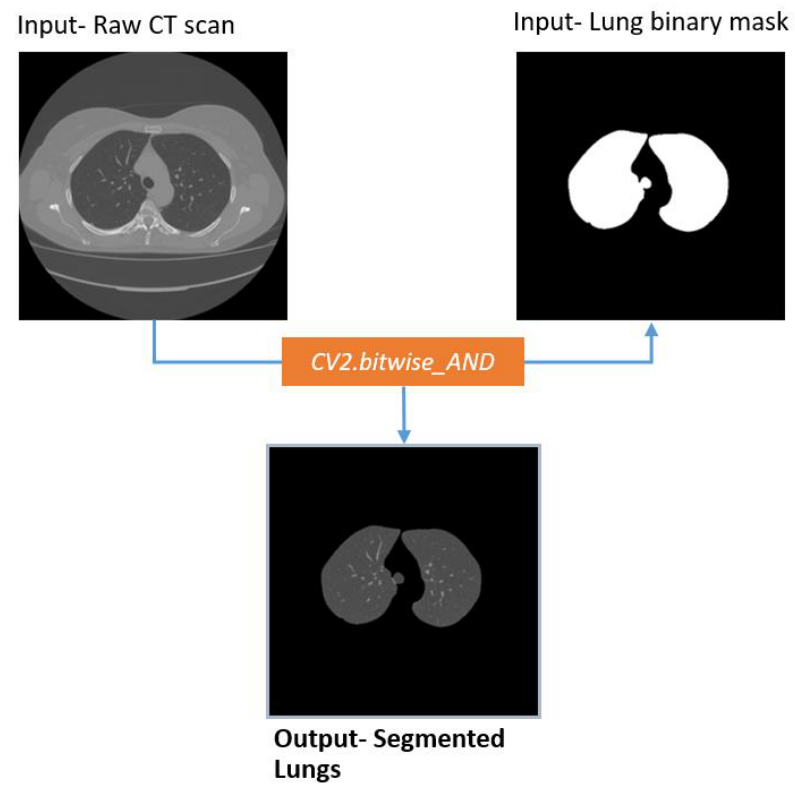
Figure 17. Extracted lungs from Raw CT scan using lung binary mask.